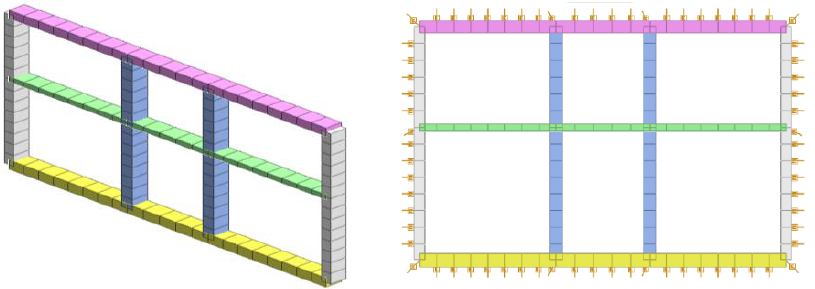
Figure 18. Calculation model and constraint diagram.